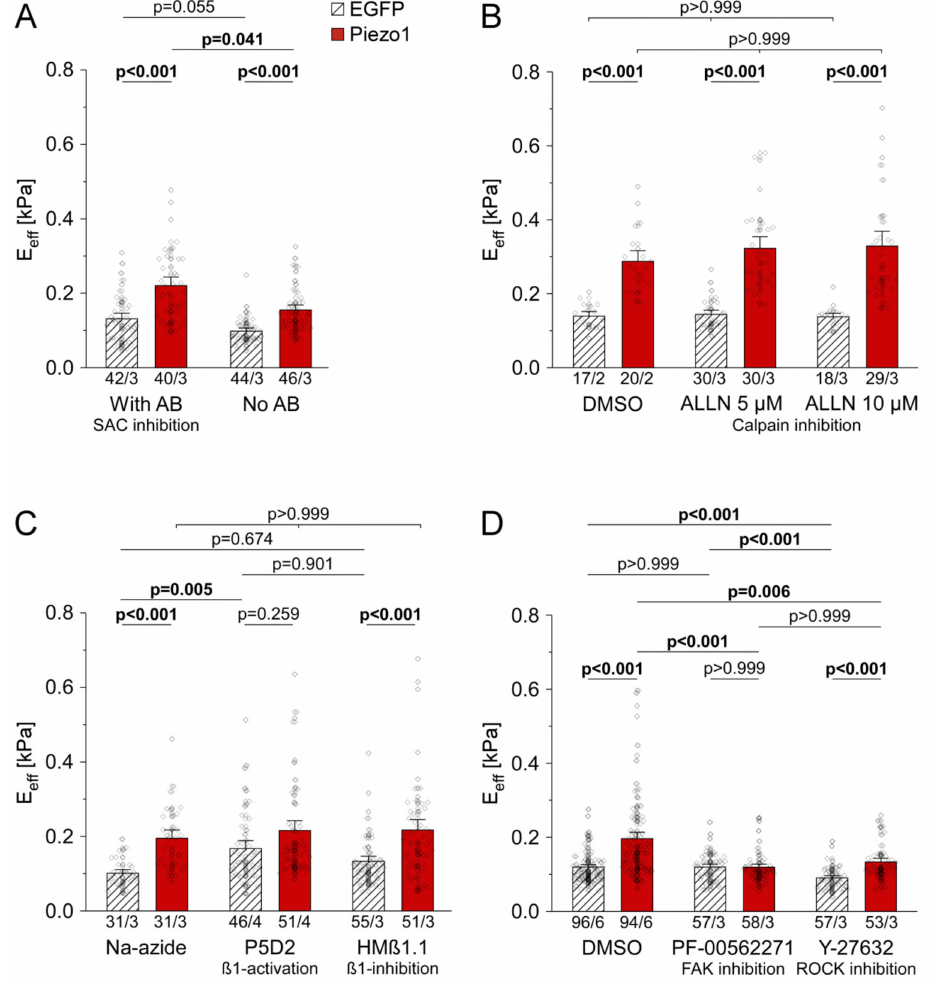
Figure 3. Piezo1-induced stiffening does not require Piezo1 channel activity at the plasma membrane, calpain activity, integrin-ß1 and ROCK, but FAK in HEK cells. Average stiffness of cells: 2 days after wash-out of antibiotics (AB, 172 µ M streptomycin and 200 µ M penicillin, ( A )); after DMSO treatment (solvent control, 0.1% v / v ) or different concentrations of the calpain inhibitor ALLN ( B ); after 2 days of treatment with Na azide (solvent control, 0.09% v / v ) or monoclonal antibodies to activate (P5D2, 2.5 µ g/mL) or inhibit (HMß1.1, 1.25 µ g/mL) integrin-ß1 outside-in signaling ( C ); after 2 days of treatment with DMSO, FAK inhibitor (PF-00562271, 1 µ M), or ROCK inhibitor (Y-27632, 1 µ M, ( D